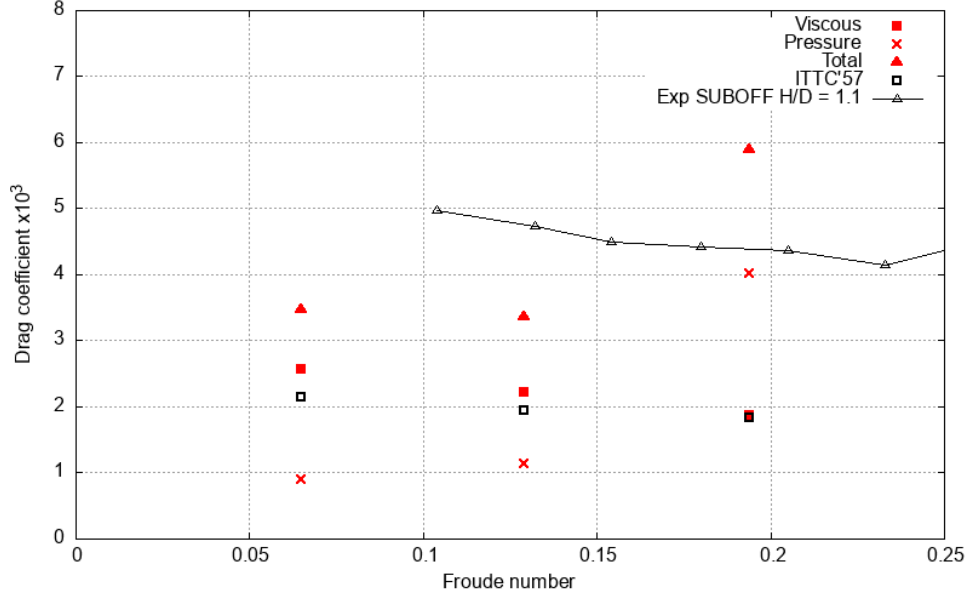
Figure 18. Total Drag coefficient vs Froude number for a Type 209/1300 submarine at condition 1 ( H / D = 0.33).